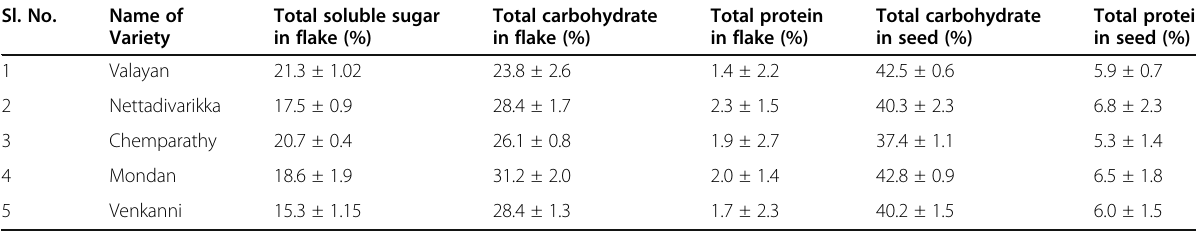
Table 1 Biochemical difference in different jackfruit varieties from Southern India [33] Sl.